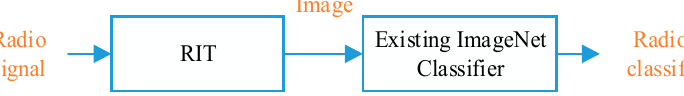
Figure 1. Radio modulation classifier architecture.